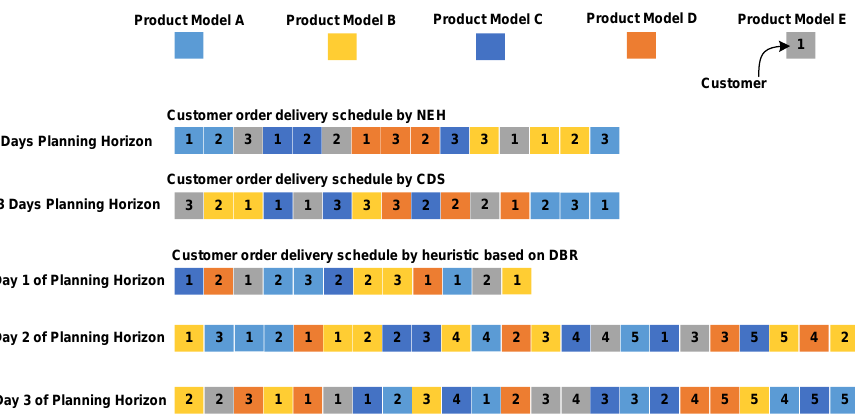
Figure 4. The scheduling results of the product models for each customer based on NEH, CDS, and heuristic based on the DBR method.